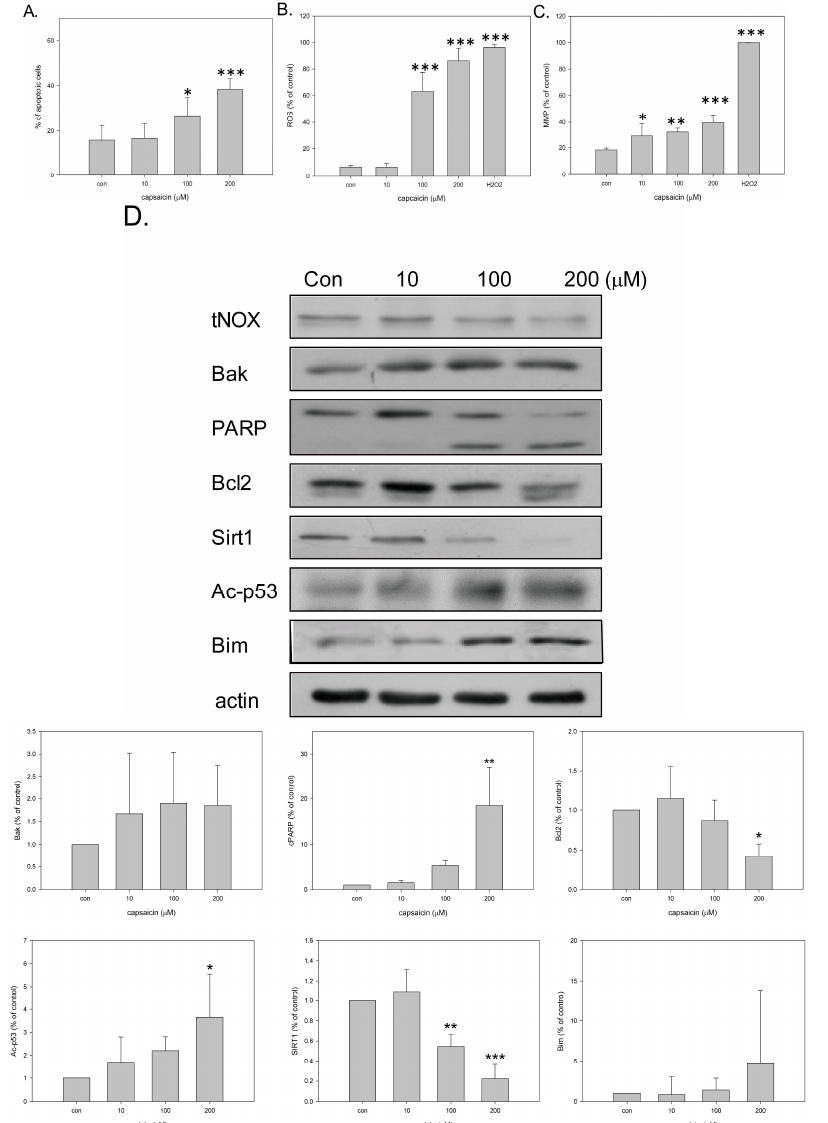
Figure 2. Capsaicin induces mitochondria-dependent apoptosis in TSGH cells. ( A ) Cells were treated with ethanol or capsaicin for 18 h. The distribution of viable (FITC/PI double-negative), early apoptotic (FITC-positive), late apoptotic (FITC/PI double-positive) and necrotic (PI-positive/FITC-negative) cells was analyzed using a Beckman Coulter FC500 flow cytometer. Both early and late apoptotic cells are included in our definition for apoptosis. Values (mean ˘ SE) are from three independent experiments (* p < 0.05, *** p < 0.001, for cells treated with capsaicin vs. controls by one-way ANOVA with LSD); ( B ) Cells were treated with ethanol or capsaicin for 6 h. ROS generation was assessed by flow cytometric analysis of H 2 DCFDA in TSGH cells and is expressed as a percentage of cells. Values (mean ˘ SE) are from four independent experiments (*** p < 0.001, for cells treated with capsaicin vs. controls by one-way ANOVA with LSD); ( C ) Cells were treated with capsaicin or ethanol for 3 h. Mitochondrial function was assessed by flow cytometric analysis of JC-10 in TSGH cells and is expressed as a percentage of cells. Values (mean ˘ SE) are from four independent experiments (* p < 0.05, ** p < 0.01, *** p <0.001, for cells treated with capsaicin vs. controls by one-way ANOVA with LSD); ( D ) Aliquots of cell lysates were separated by SDS-PAGE and analyzed by Western blotting; β -actin was used as an internal control. Representative images are shown. The intensity of a protein band was quantified by Gel-Pro Analyzer software 3.1The resultant values of protein expression were normalized to those of actin. Values (mean ˘ SE) are from three independent experiments (* p < 0.05, ** p < 0.01, *** p <